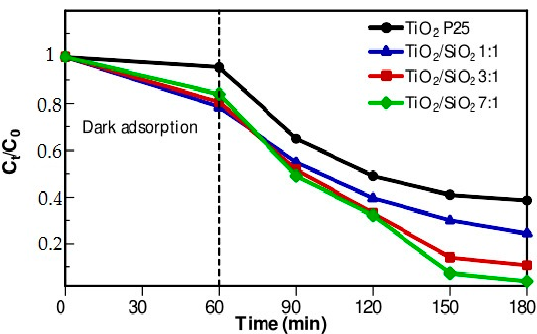
Figure 7. The normalized concentration of the photocatalytic phenol removal using TiO 2 P25 and various TiO 2 /SiO 2 ratios. The experiment was conducted using 50 mL phenol solution 20 mg.L − 1 and 75 mg catalyst.